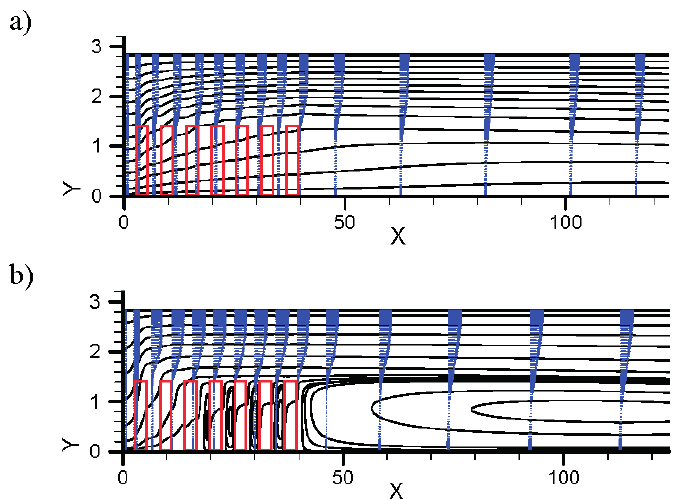
Figure 1. The upper half of the single-column flow field in seven-rows heat-sink array (the direction of pin fins is pointing the Z -axis vertical to paper surface): ( a ) high-permeability heat-sink array and ( b ) low-permeability heat-sink